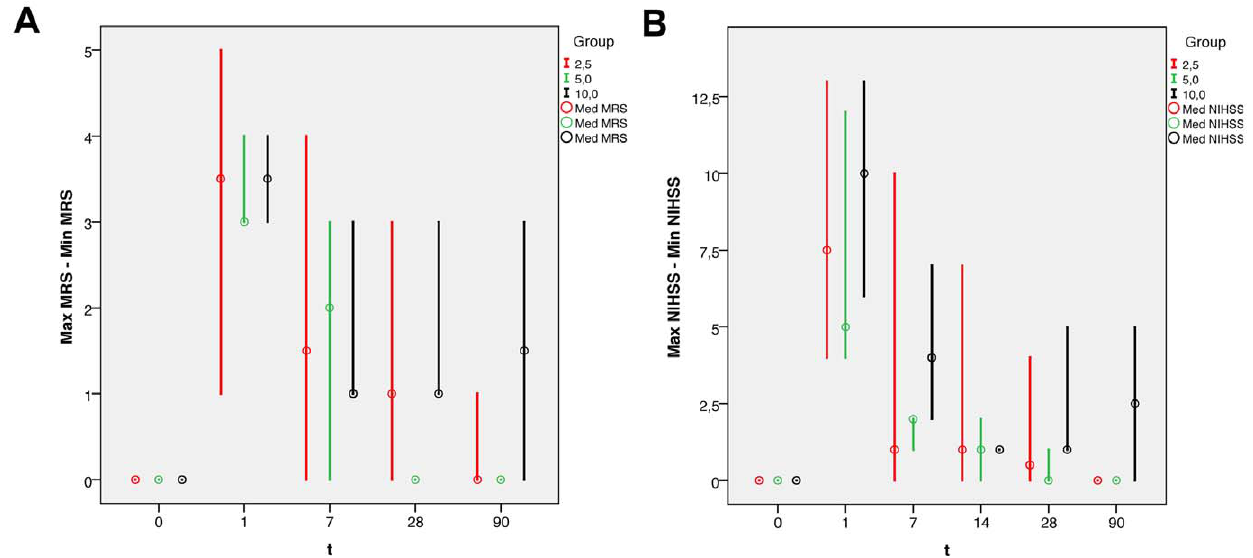
Figure 1. Scores over time. MRS (Modified Rankin Scale) scores over time as median with minimum and maximum in three different dosage groups (A). NIHSS (National Institutes of Health Stroke Scale) scores over time as median with minimum and maximum in three different dosage groups (B).